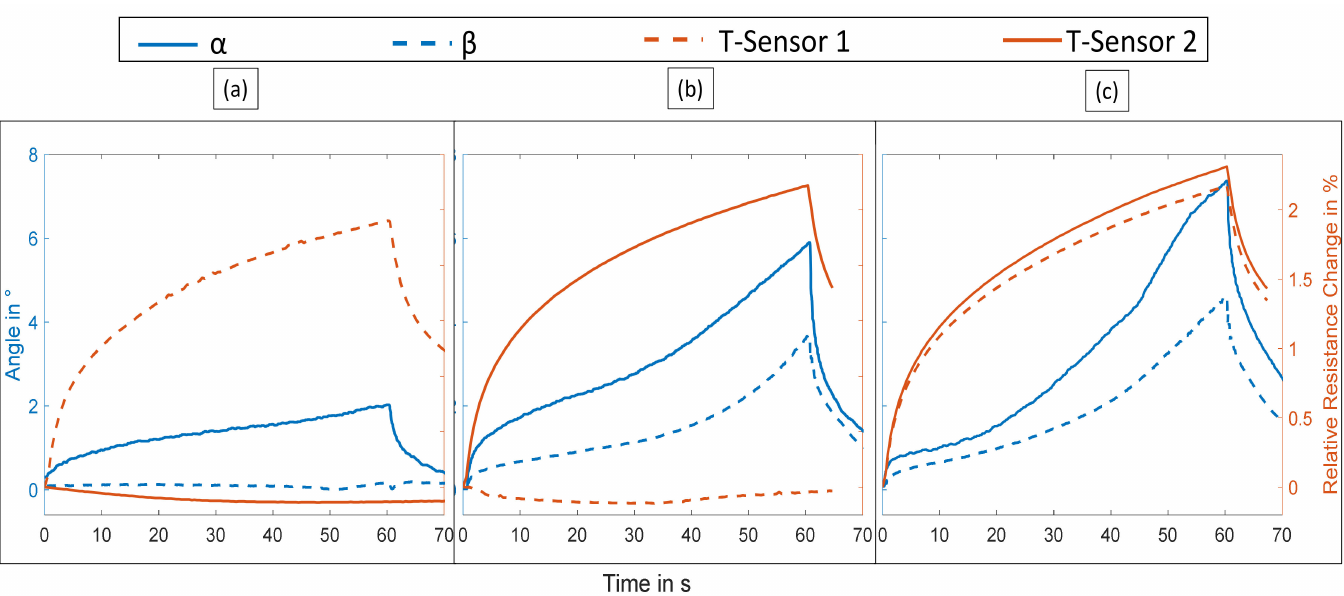
Figure 4. Deformation and resistance change of the temperature sensor in the braided sheath when a current of 1.1 A was run through the SMA wires for 60 s: ( a ) SMA wire 1 activated; ( b ) SMA wire 2 activated; ( c ) SMA wires 1 and 2